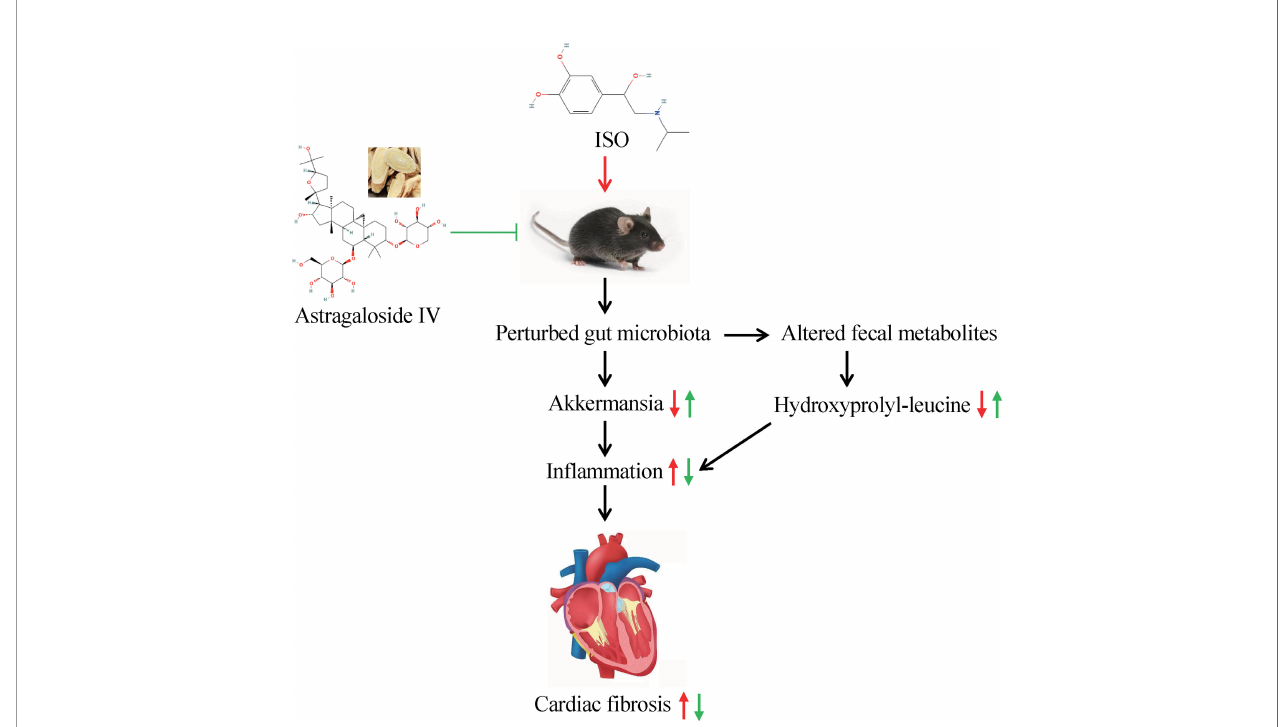
FIGURE 8 | Mechanism of AS-IV on gut microbiota in ISO-induced cardiac fi brosis